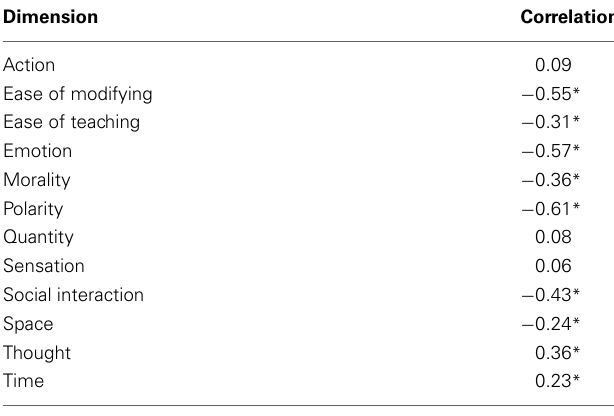
Table 3 | Correlation of concreteness and dimension SD